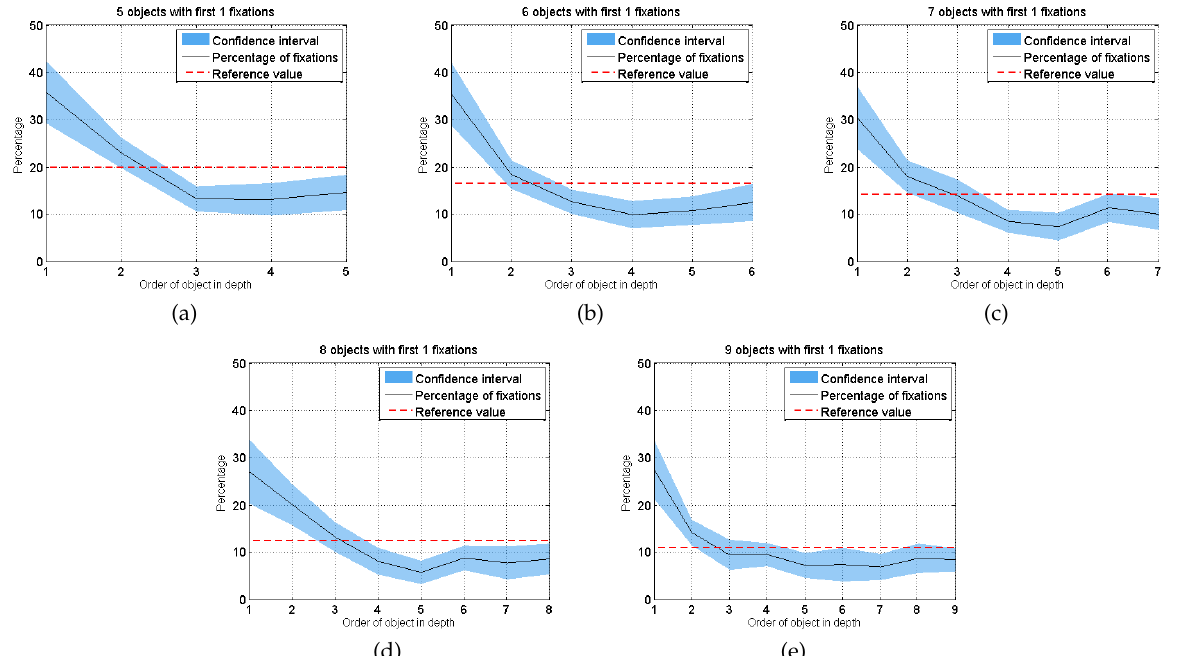
Figure 5 . Fixation distribution (only the first fixation was considered) as a function of the order of object’s depth for the scenes containing different numbers of objects ( N ∈ 5 , 6 , 7 , 8 , 9 ). X axis is the order of objects; sub-figure (a) to (e) represent the group of scenes that contain 5 to 9 objects, respectively. Y axis represents the percentage of number of fixations. The blue area represents the 95% confidence interval. The dash line represents the uniform probability distribution ( 1 / N ).